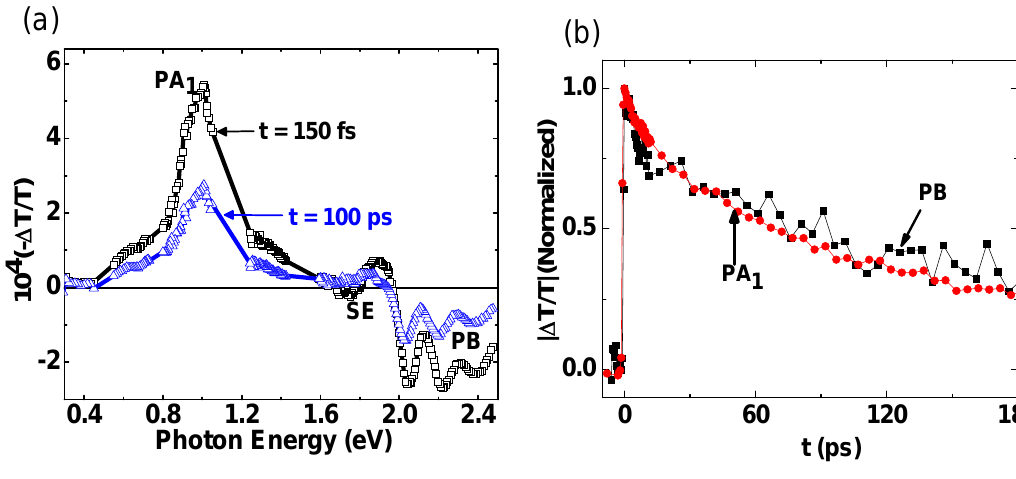
, SE and PB are 1 and PB bands up to t = 180 1